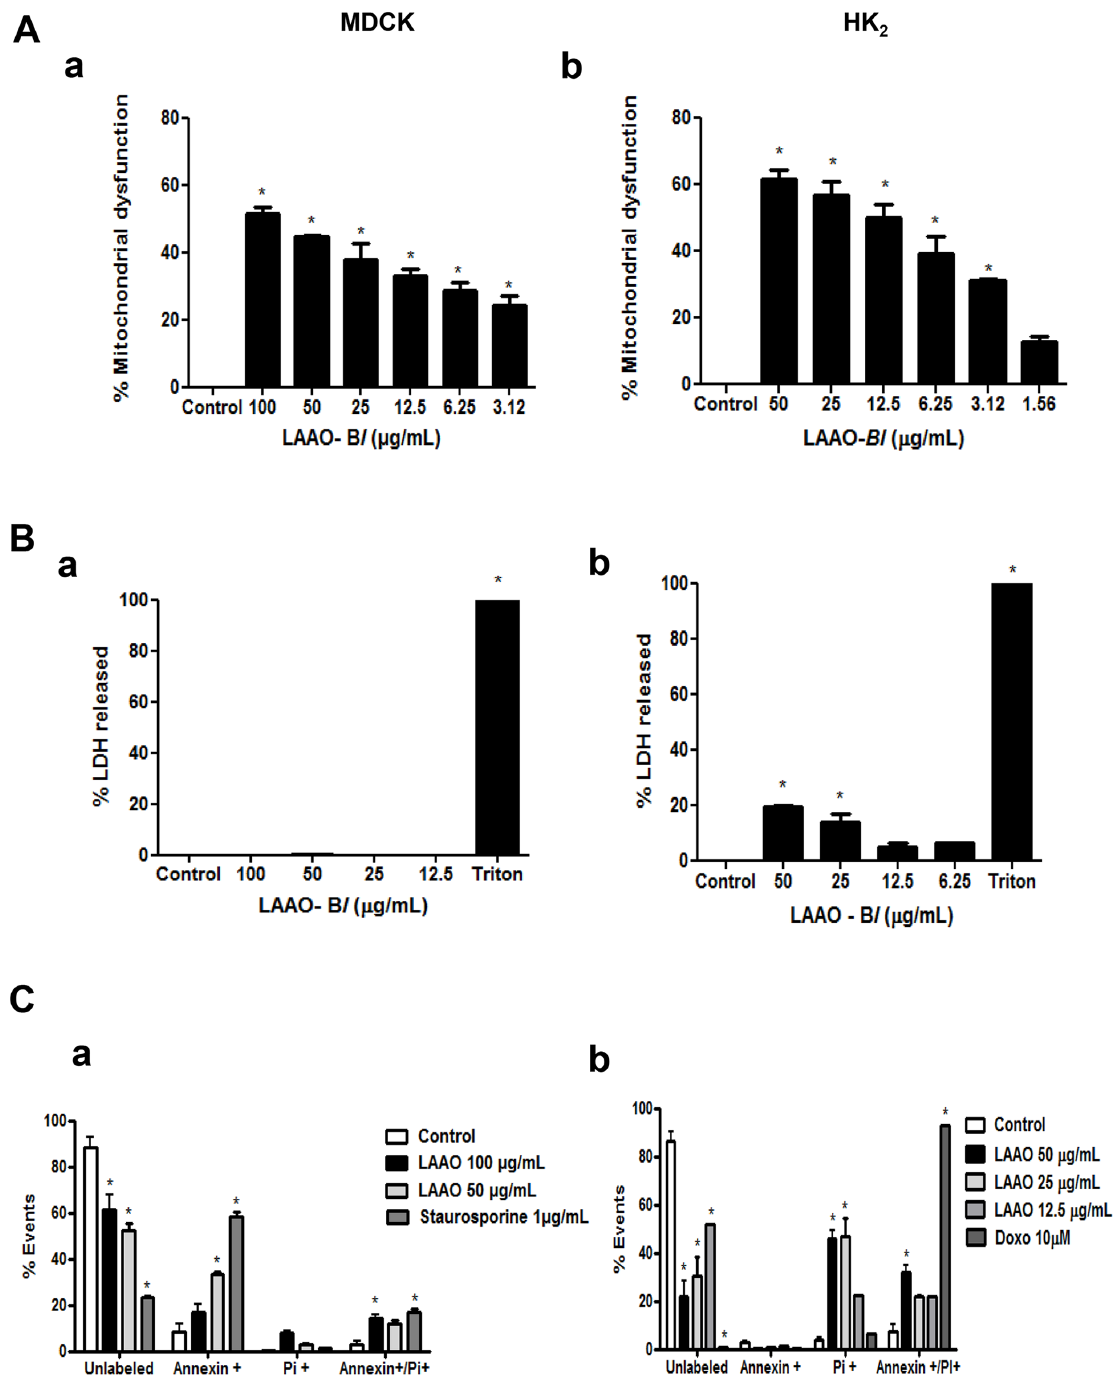
Fig 1. LAAO- Bl induces necrosis and apoptosis in renal epithelial cell lines. (A) MDCK (a) and HK-2 (b) cells were treated with LAAO- Bl (1.56 – 50/ 100 μ g/mL) for 12 h. After treatment, cell viability was determined by MTT. (B) Percentage release of the lactate dehydrogenase enzyme of MDCK (a) and HK-2 (b) cells treated with the indicated concentrations of LAAO- Bl . Triton (7%) was used as positive control. (C) Annexin V + /PI - , Annexin V + /PI + and AnnexinV - /PI + -populations were analyzed by flow cytometry in MDCK (a) and HK-2 (b) cells for 12 h after treatment with LAAO- Bl . Staurosporine (1 μ g/mL) and doxorubicin (10 μ M) for 12h were used as positive controls. All data are representative of three independent experiments in triplicate and are expressed as mean ± S.E.M. * Significantly different from control group (p < 0.05, one way ANOVA, Dunnett post-test).